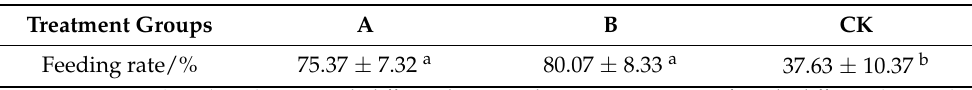
Table 7. Acceptability of cat food attractants in different groups. Group A: Blank cat food + 3% self-made attractants. Group B: Blank cat food + 3% commercial attractants. Group CK: Blank cat food. Different letters in different groups indicate significant differences ( p < 0.05).